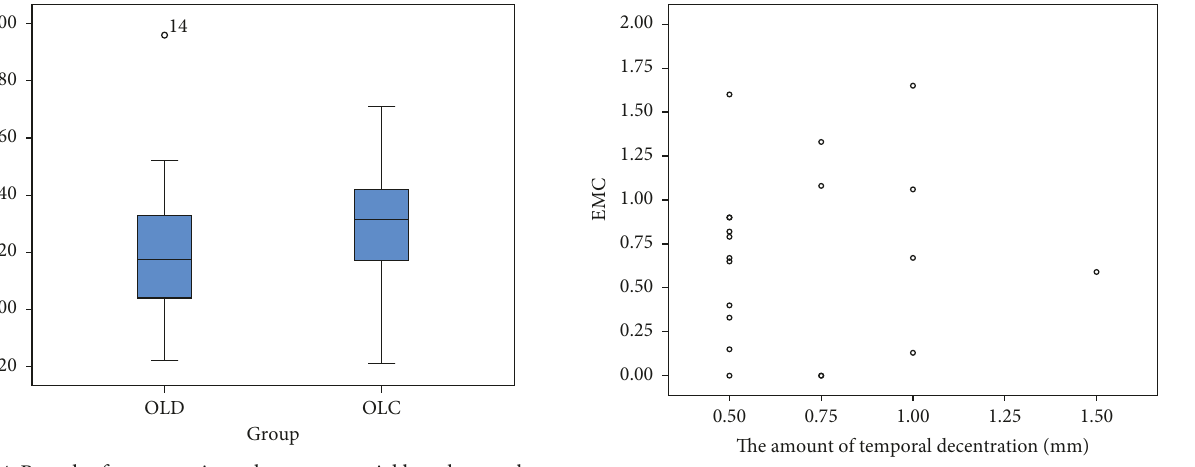
Figure 5: Scatter plot for relationship between EMC and the amount of decentration in 20 eyes with temporal decentration.